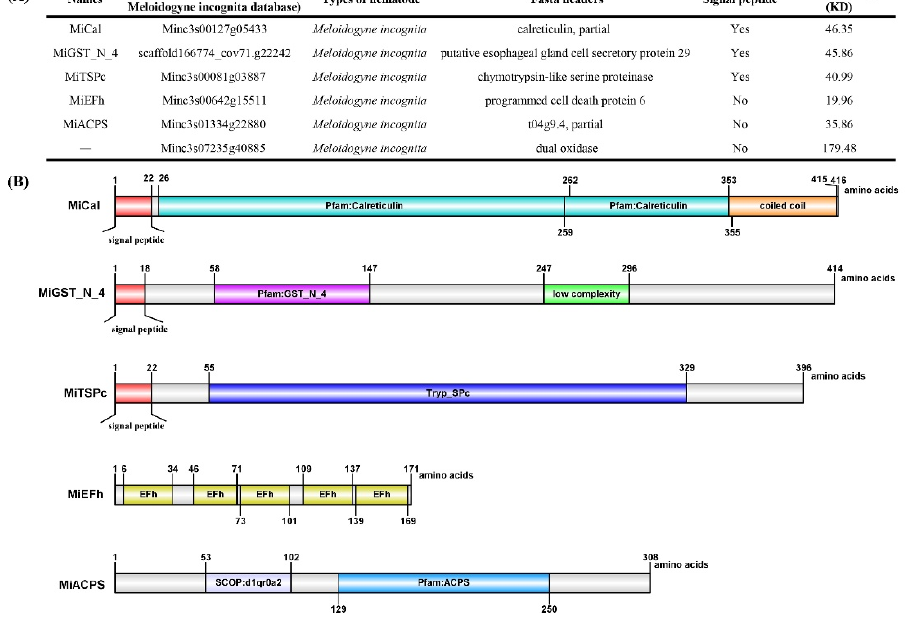
Figure 1. ( A ) Effector proteins from Meloidogyne incognita obtained by immunoprecipitation (IP) combined with liquid chromatography coupled with a tandem mass spectrometry (LC ‐ MS) assay, showing their accession number in the M. incognita database, signal peptide status and protein molecular weights. ( B ) The characteristics of the five effectors of M. incognita .